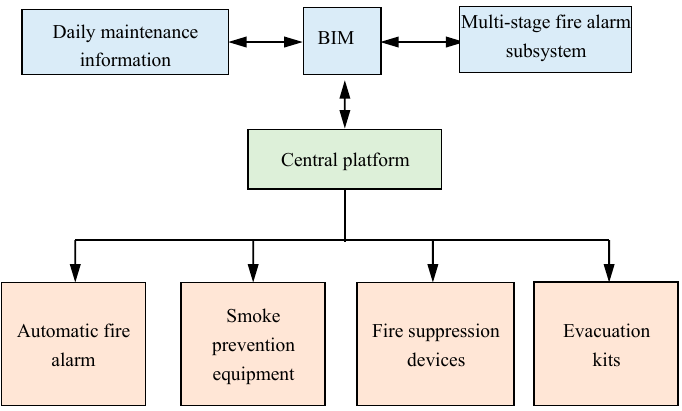
Figure 4. Control process of the control system in the remote monitoring subsystem.